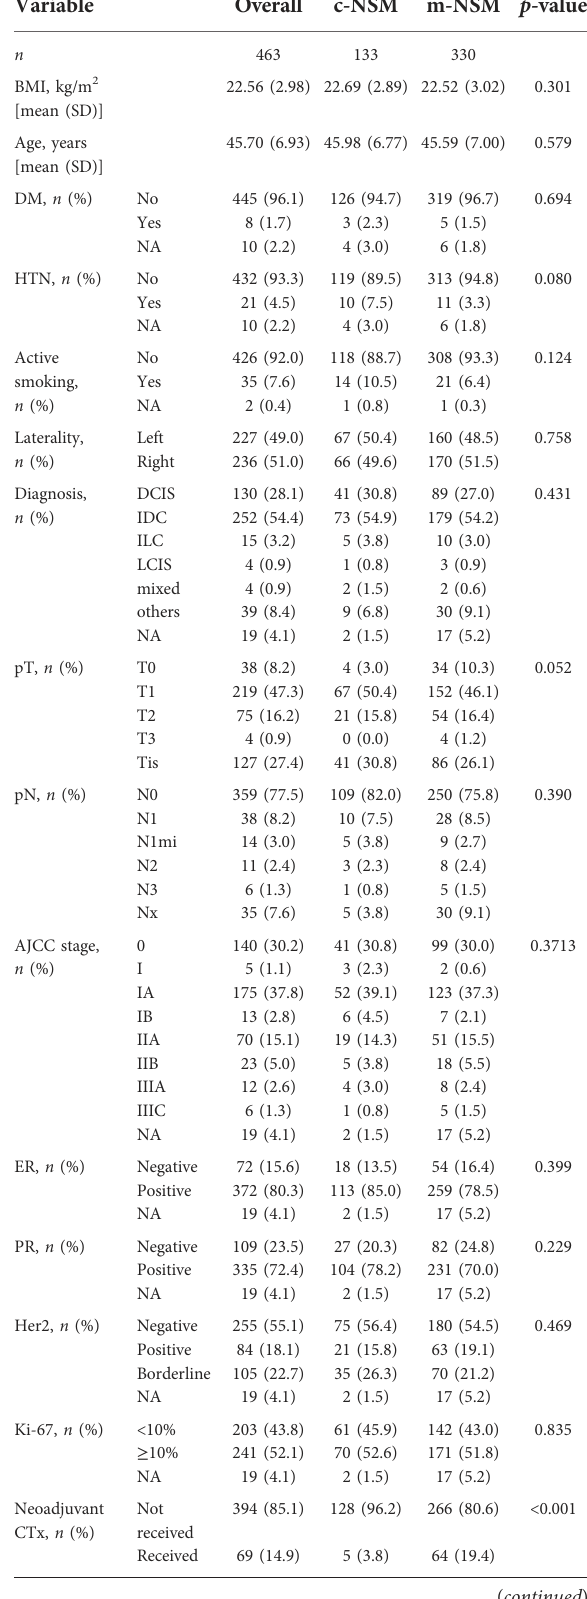
TABLE 1 Patient characteristics by mastectomy type ( N